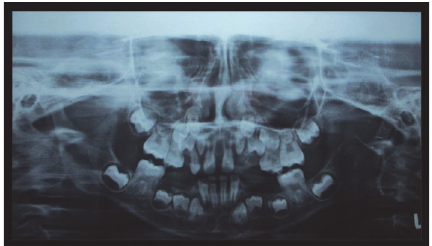
Figure 3: Panoramic radiograph showing lack of primary dentition tooth buds.